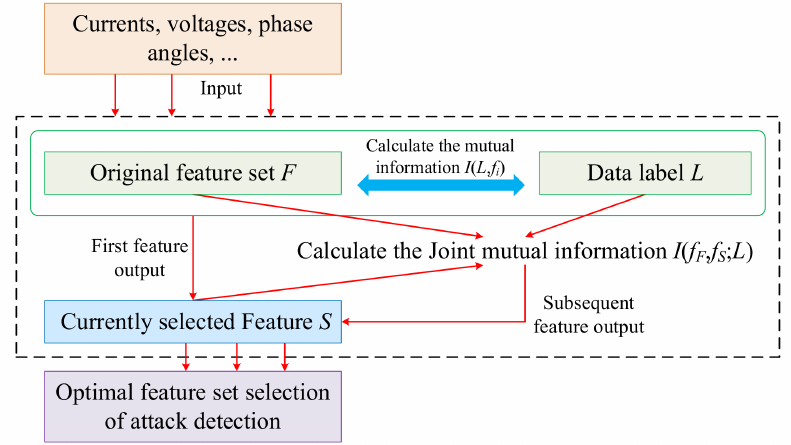
Figure 4. Optimal feature set selection process of attack